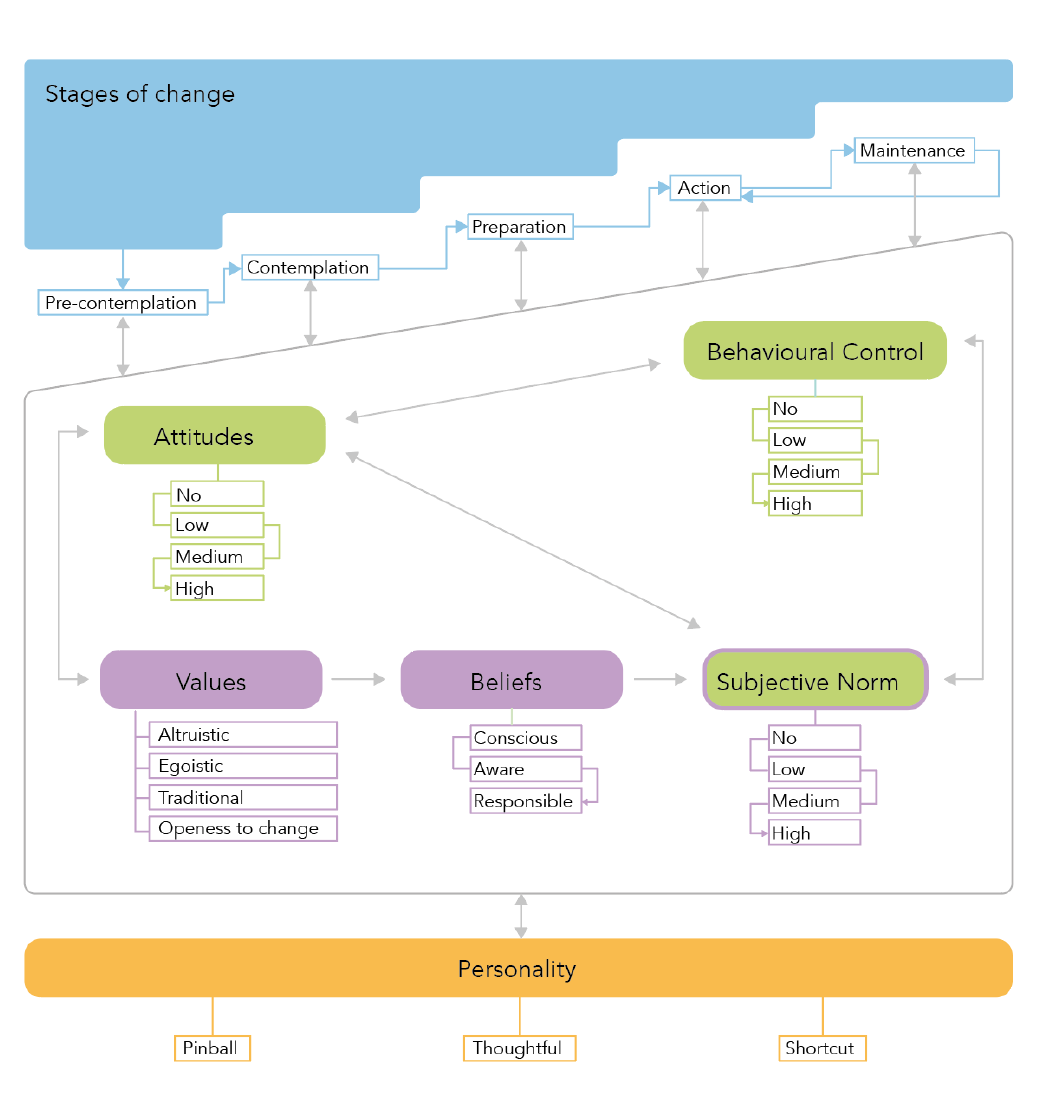
Figure 4. The FOX model with the specific dimensions and